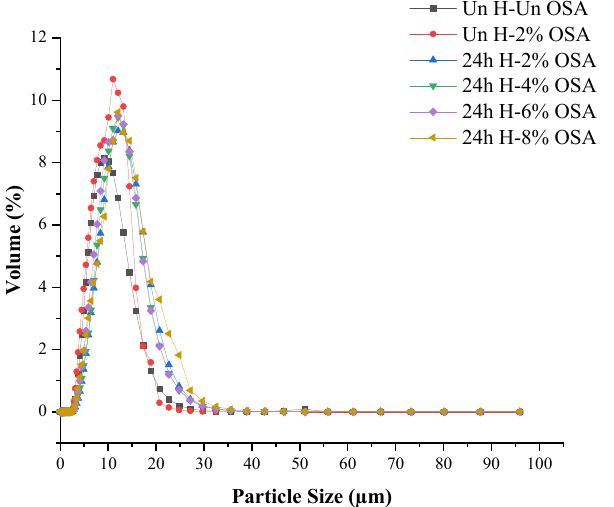
Figure 4. Mean granule size of native and OSA-modified high-amylose PMS (Kudzu) starch samples.